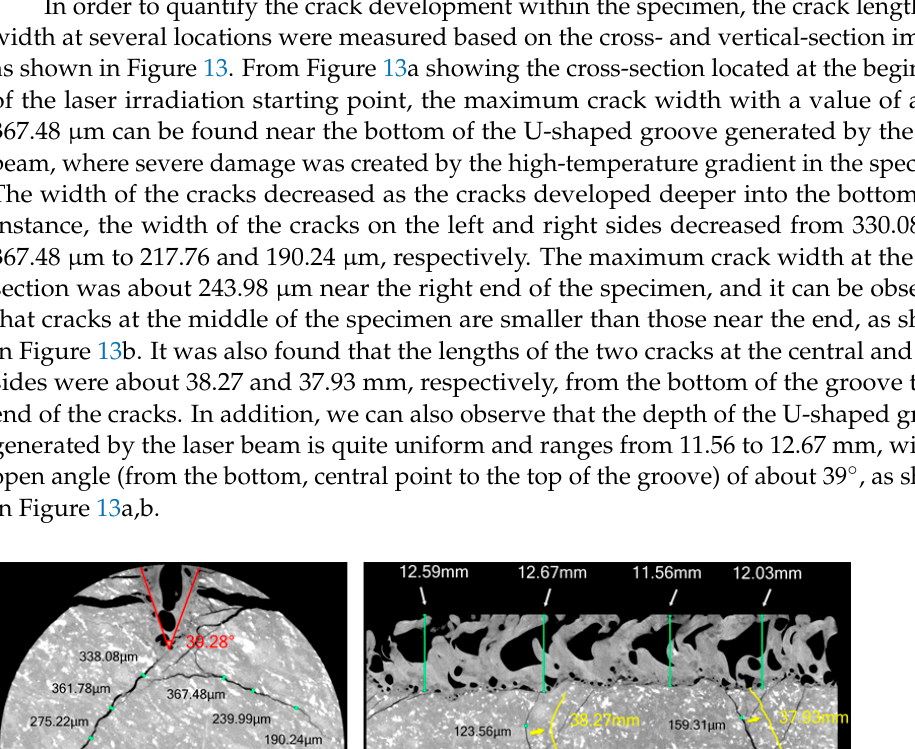
Figure 12. Interior-crack images of vertical section at ( a ) axis and ( b ) 3/4 diameter plane.